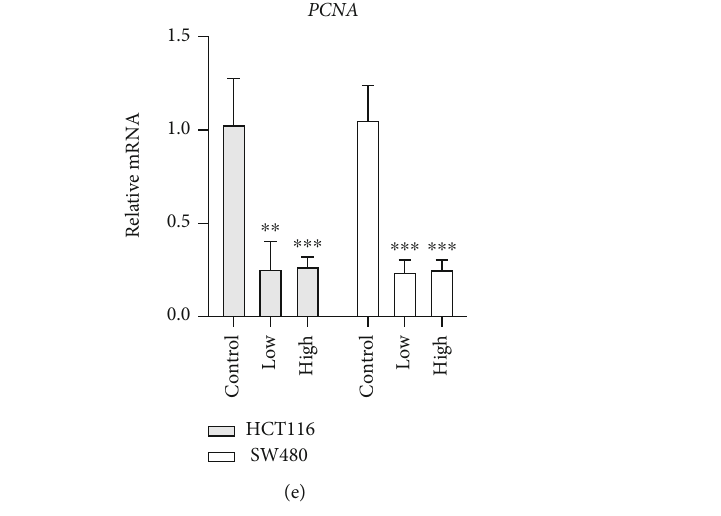
Figure 2: Feno fi brate administration inhibited colon cancer cell proliferation. (a) HCT116 and SW480 cells were treated with a range of concentrations of feno fi brate for 24h. Cell viability was detected using CCK8. (b) EDU staining of cells was observed after incubation with feno fi brate for 24 h (magni fi cation 200x). Box plot showing the statistics of fl uorescence intensity. (c) Colony formation of cancer cells with or without feno fi brate treatment. (d) The PCNA immuno fl uorescence staining results of cells (magni fi cation 200x). (e) The mRNA expression level of PCNA was measured following feno fi brate treatment. Data was presented as mean ± SD . The experiment was repeated three times with three replicates per experiment ( ∗ P < 0 : 05 , ∗∗ P < 0 : 01 , ∗∗∗ P < 0 : 001